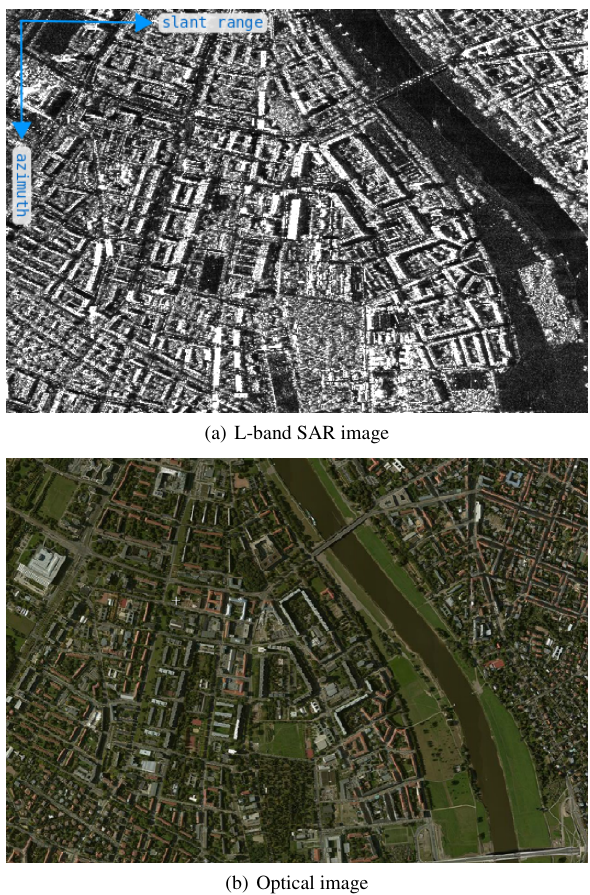
Figure 3: (a) SAR and (b) optical images of the selected area. Dimensions of the cropped SAR image are approximately of 700 pixels in azimuth and 1000 pixels in range. The optical image is from c Microsoft Bing Maps, 2015  antenna emits an electromagnetic pulse that illuminates a terrain patch and receives the backscattered signal due to the